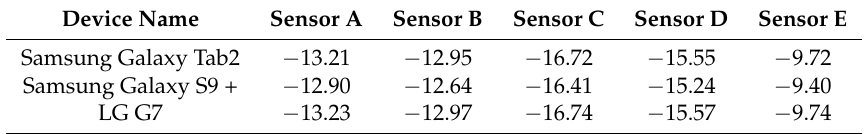
Table 1. Difference of received signal strength of mobile devices and that of sensors in